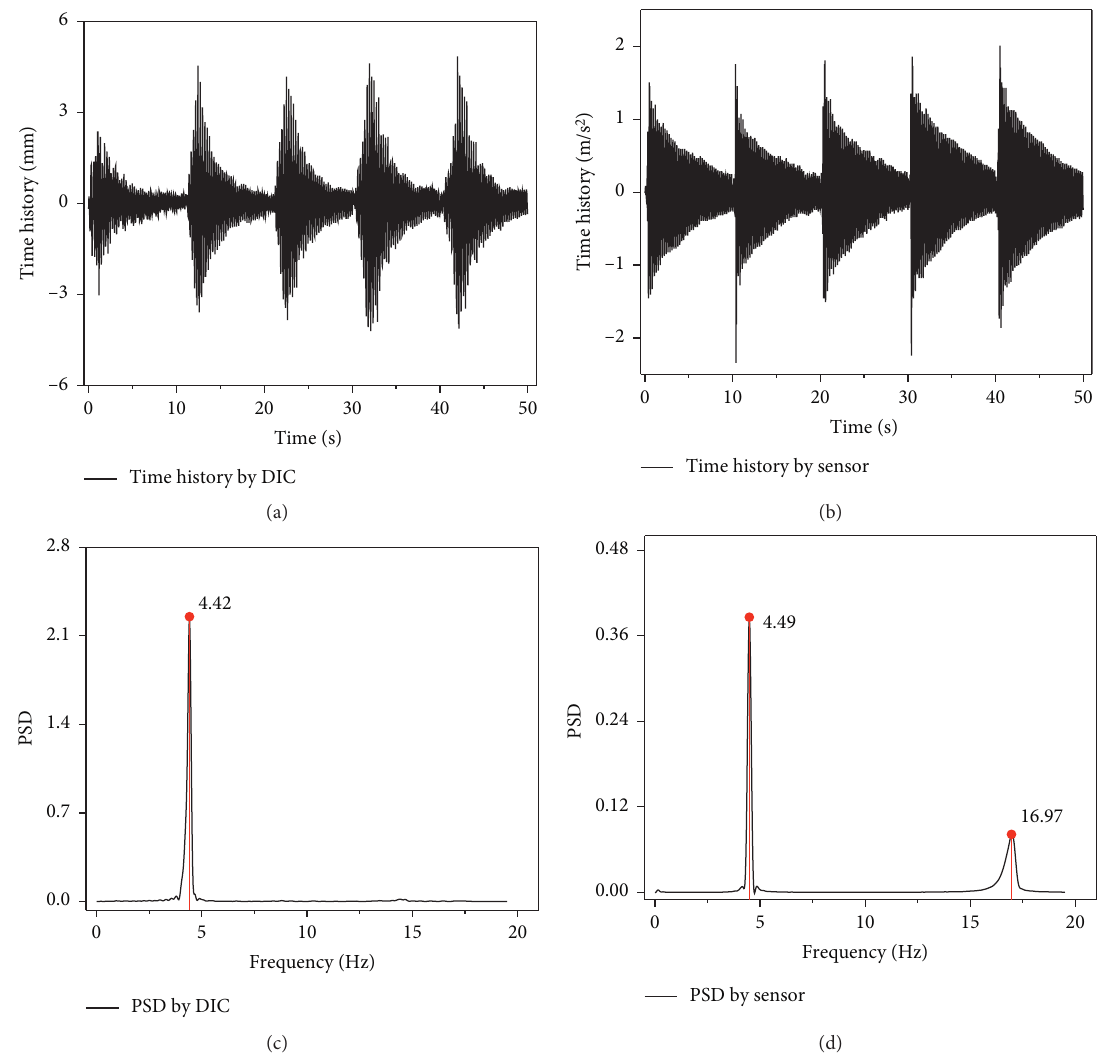
Figure 5: Comparisons of measurements by the DIC and sensor. (a) Time history by DIC. (b) Time history by the sensor. (c) PSD by DIC. (d) PSD by the